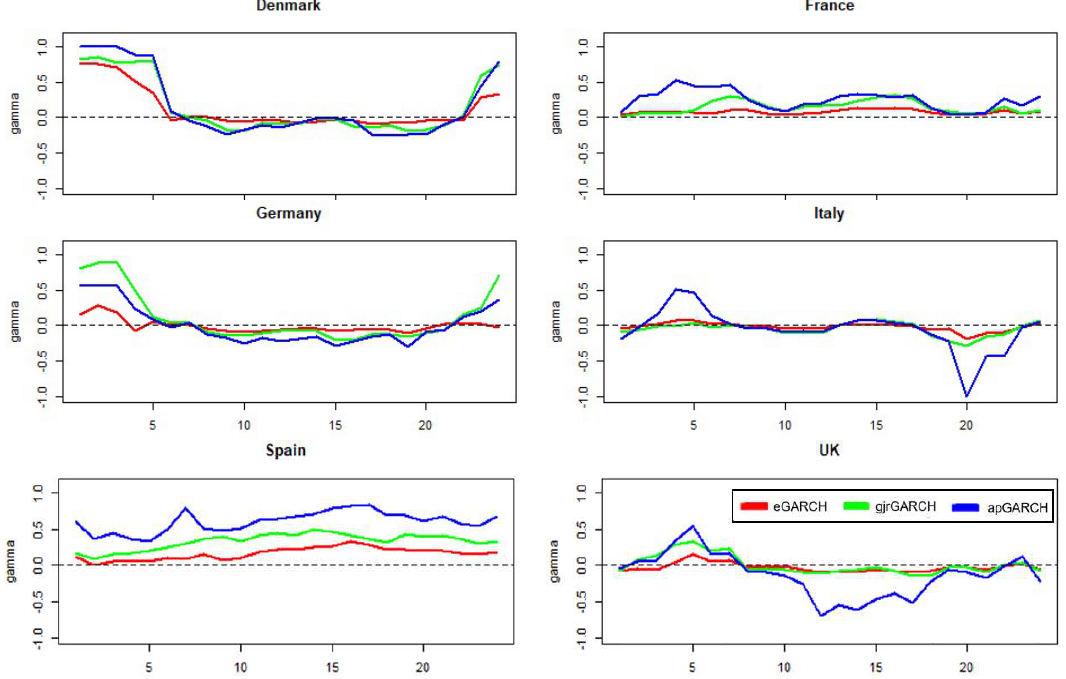
Figure 10. The γ estimates for the gjrGARCH and apARCH models and the α parameter (with sign changed) for the eGARCH model.